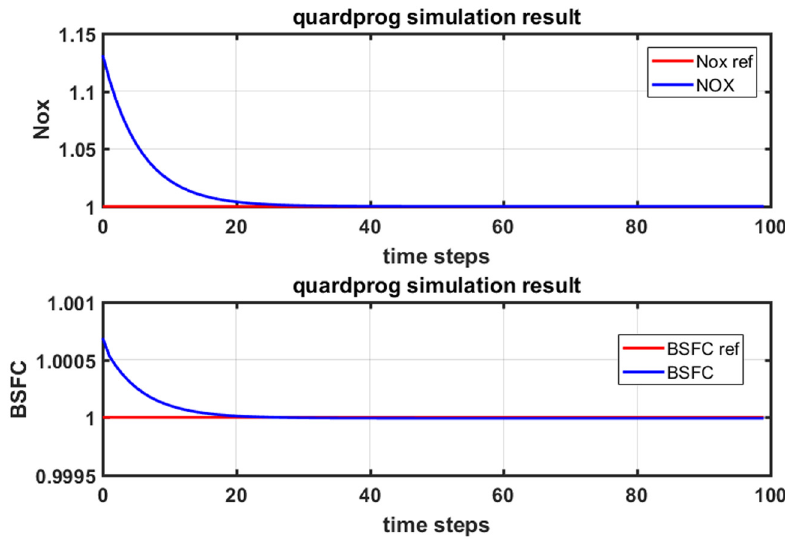
Figure 4: Simulation result system outputs from the quadprog